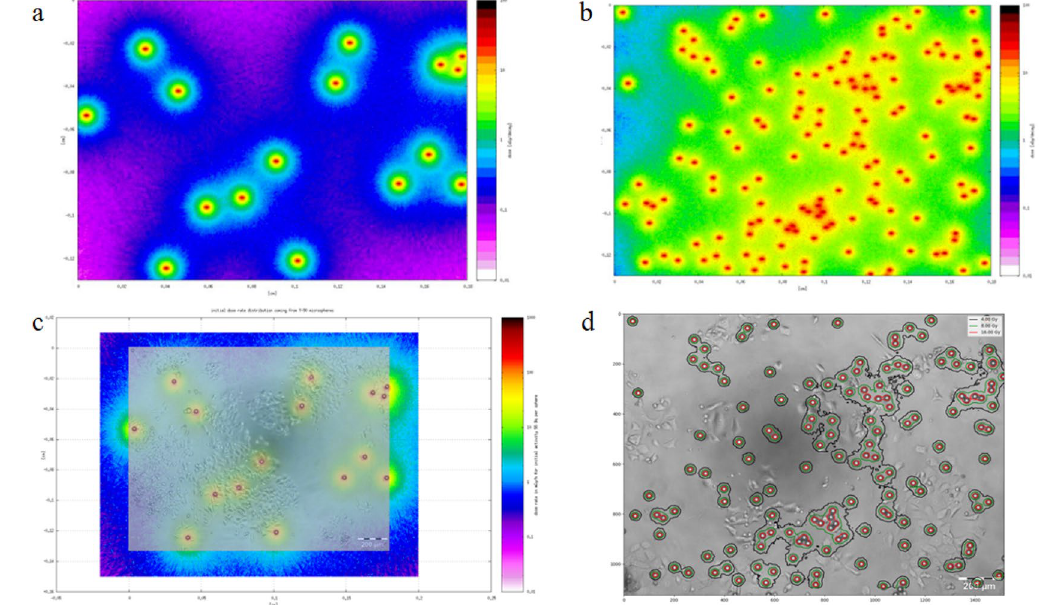
Figure 4. Absorbed dose distribution in cell culture wells shown with the FLUKA simulation package. ( a , b ) showing total absorbed dose distribution for a variable number of spheres. ( c ) shows superposition of the microscopic image of cells and microspheres, and simulated dose rate distribution coming from the spheres. ( d ) illustrates dose distribution on the microscopic image as isodoses. Software: FLUKA2011 Version 2x.4 Nov-18 (https ://www.fluka .org/fluka .php?id=secur ed_intro